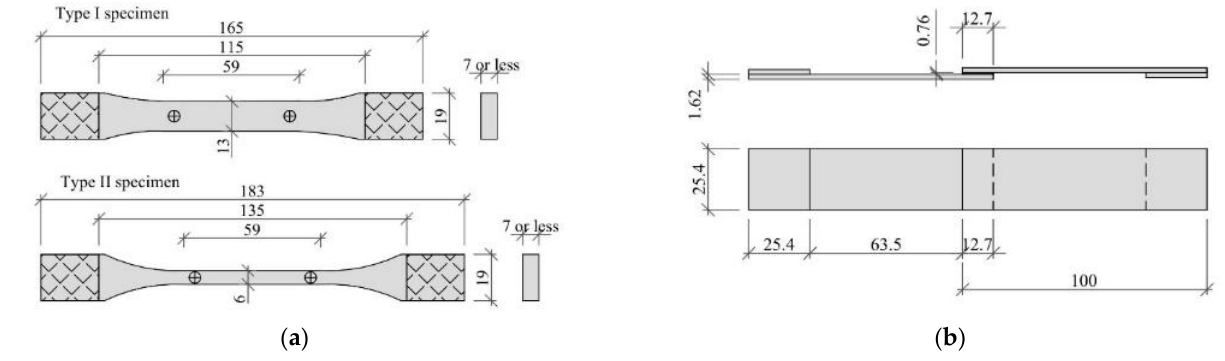
Figure 6. Geometry of the tested specimen: ( a ) according to standard [45]; ( b ) according to standard [46].